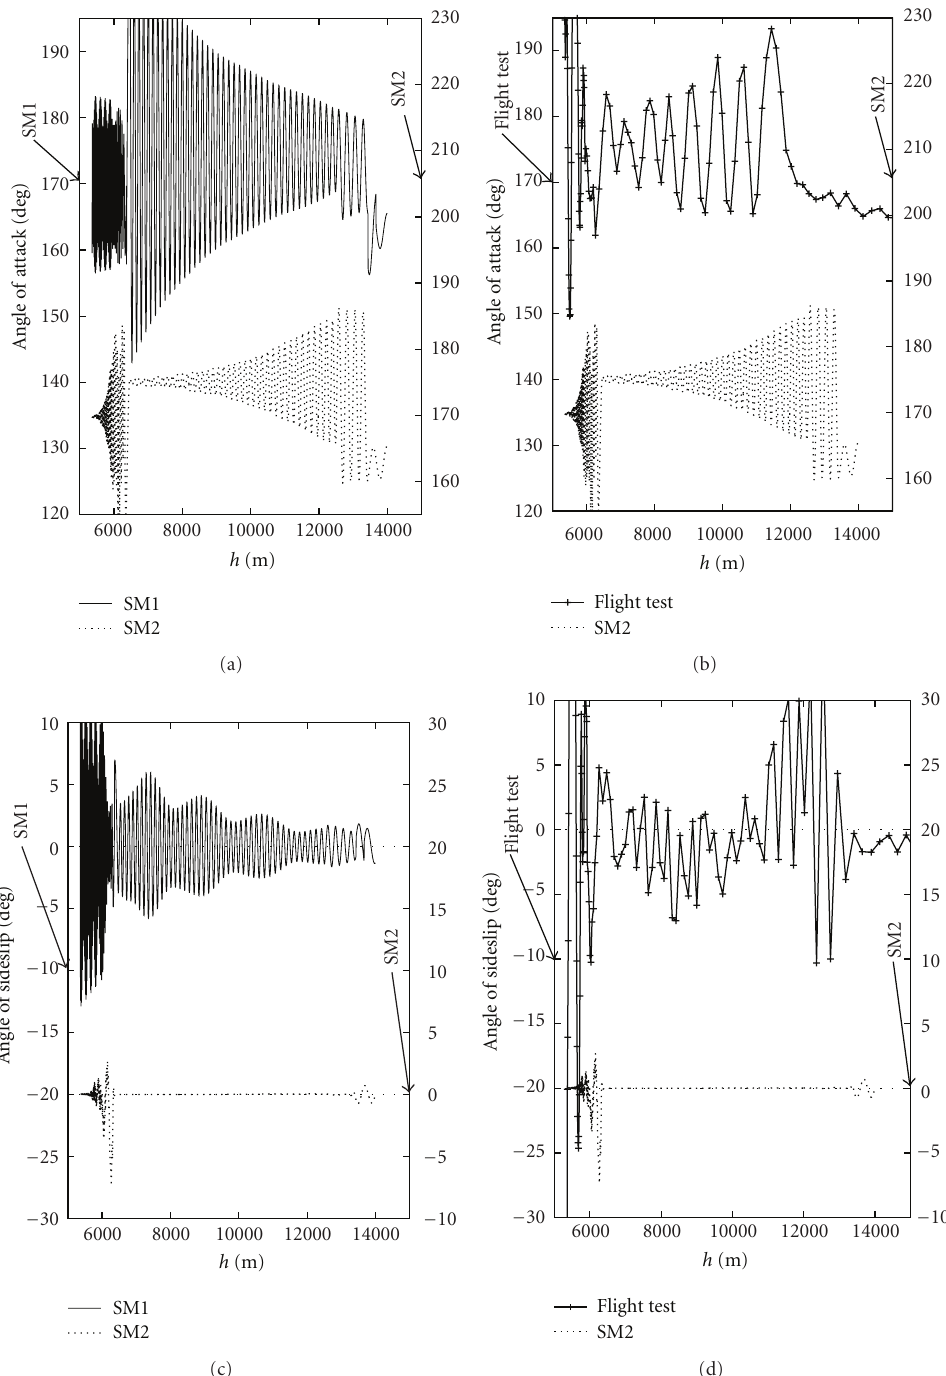
Figure 8: The simulation of the angles of attack and sideslip for the payload. traces for the lateral-directional plane. This is the impact of The aerodynamic angles of the payload are plotted in the aerodynamic model adopted for the payload, which for Figure 8. The major discrepancy between the two models the SM1 case decouples and superimposes the e ff ects for the is the level of dynamic stability of the modal response longitudinal and the lateral-directional planes. The use of (short-period dynamics). This can be explained with the total angle of attack for the interpolation and reconstruction extreme sensitivity of the aerodynamic coe ffi cients to center of payload aerodynamic coe ffi cients (as in SM2 model) of gravity location and angle of attack (see Figures 9 and provides a more accurate fit. 10). Remind that the center of gravity location is